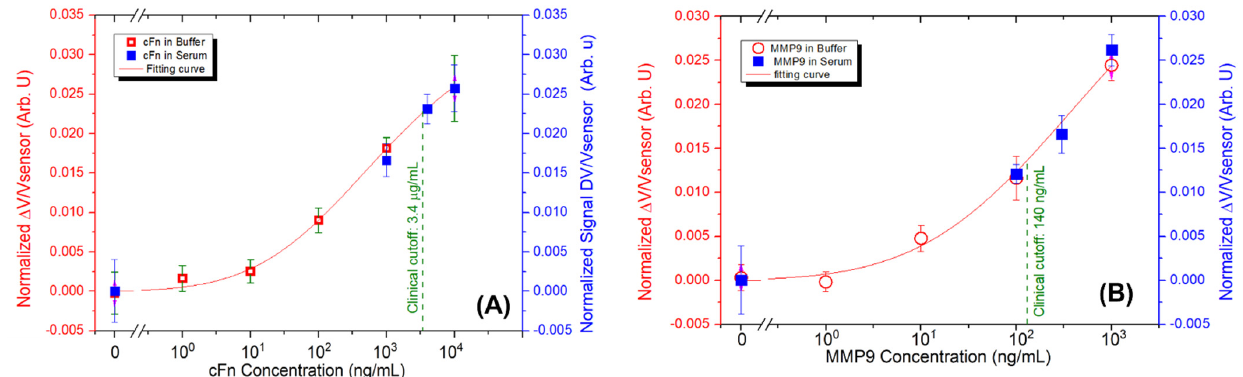
Figure 6. Quantification of c-Fn ( A ) and MMP9 ( B ) in the human serum-based matrix (blue) near the relevant clinical cutoff regions. Measurements were cross-validated with the calibration curve obtained using the biomarkers spiked in a phosphate buffer (red). The green dash depicts the clinical cutoff value for each biomarker.